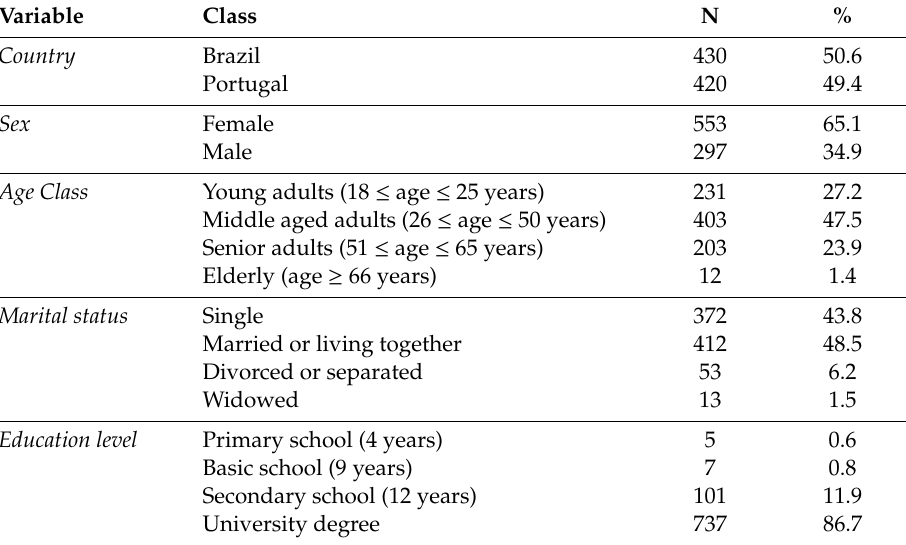
Table 1. Sociodemographic characteristics of the